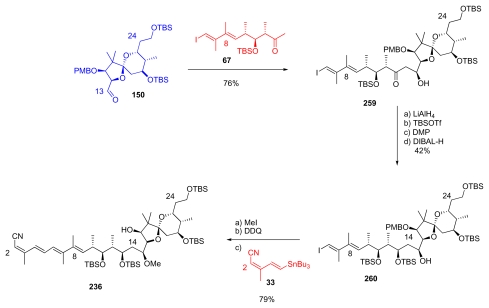
Preparation of the C1–C25 fragment 236 by Barrett.